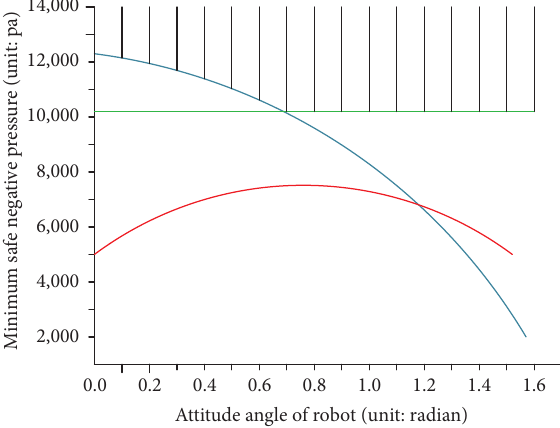
Figure 6: Suction pressure needed while the robot is